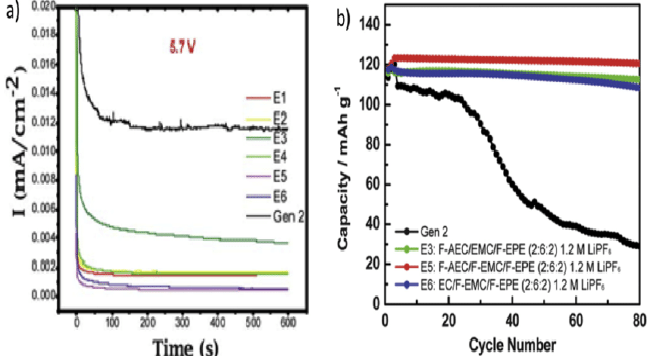
Figure 9. ( a ) Electrochemical potential window of Gen2 and fluorinated electrolytes E 1 –E 6 at 5.7 V utilizing a traditional cell with three electrodes. ( b ) Cycling capacity retention of lithium titanate (Li 4 Ti 5 O 12 ) (LTO)/LNMO cells with baseline electrolyte (Gen2) and fluorinated electrolytes E 3 , E 5, and E 6 at 55 °C. Gen2: 1.2 M LiPF 6 in EC/EMC (3:7); E 1 : EC/EMC/F-EPE (2:6:2) 1.2 M LiPF 6 ; E2: EC/EMC/F-EPE (2:5:3) 1.2 M LiPF 6 ; E3: F-AEC/EMC/F-EPE (2:6:2) 1.2 M LiPF 6 ; E 4 : F-AEC/EC/EMC/F-EPE (1:1:6:2) 1.2 M LiPF 6 ; E 5 : F-AEC/F-EMC/F-EPE (2:6:2) 1.2 M LiPF 6 ; E3: EC/F-